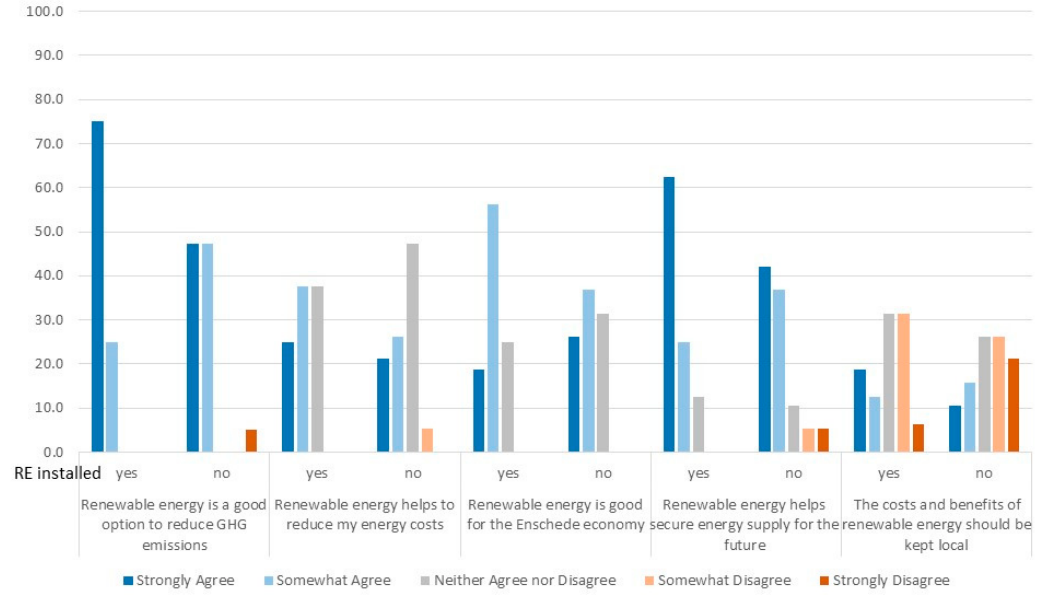
Figure 4. Participants’ perception of renewable energy.